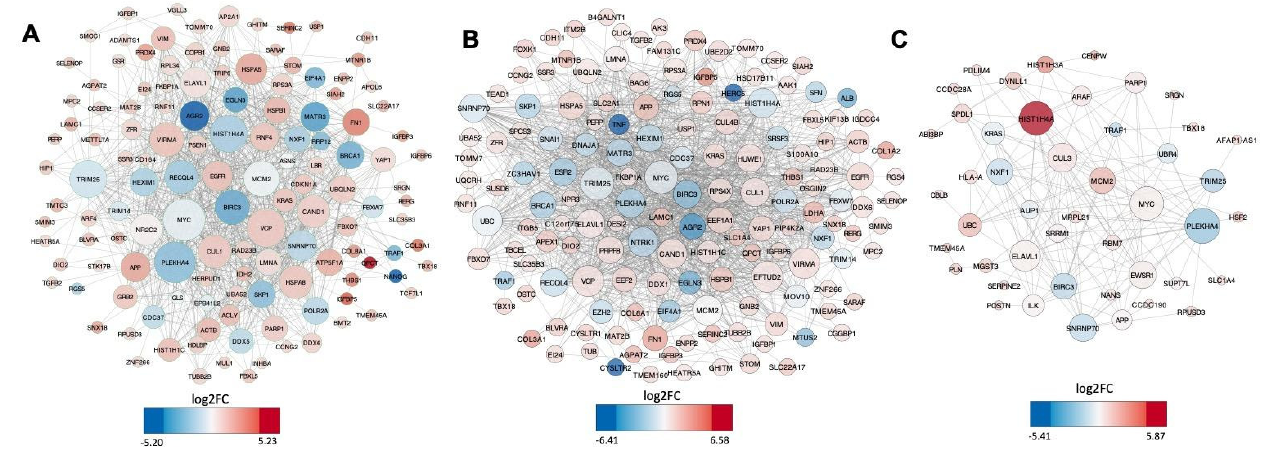
Figure 4. Networks of protein–protein interaction of DEGs related to the DEHERVs nearby genes. ( A ) ChikV; ( B ) MayV; ( C ) OroV. Each network is composed of a unique connected component with high connectivity.